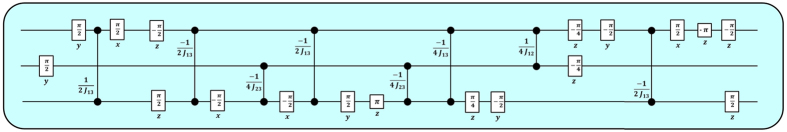
Controlled-SWAP.Quantum interferometric approach based on the Controlled-SWAP gate that provides the measure of the overlap . The boxes represent rotations applied to invidual qubits. The angles and phases of these rotations are indicated inside and below the boxes, respectively. Refocusing pulses are not shown. The free evolutions are represented by black dots connected by lines where the interaction of the two qubits, indicated by the dots, took place, for the time indicated in the figure.